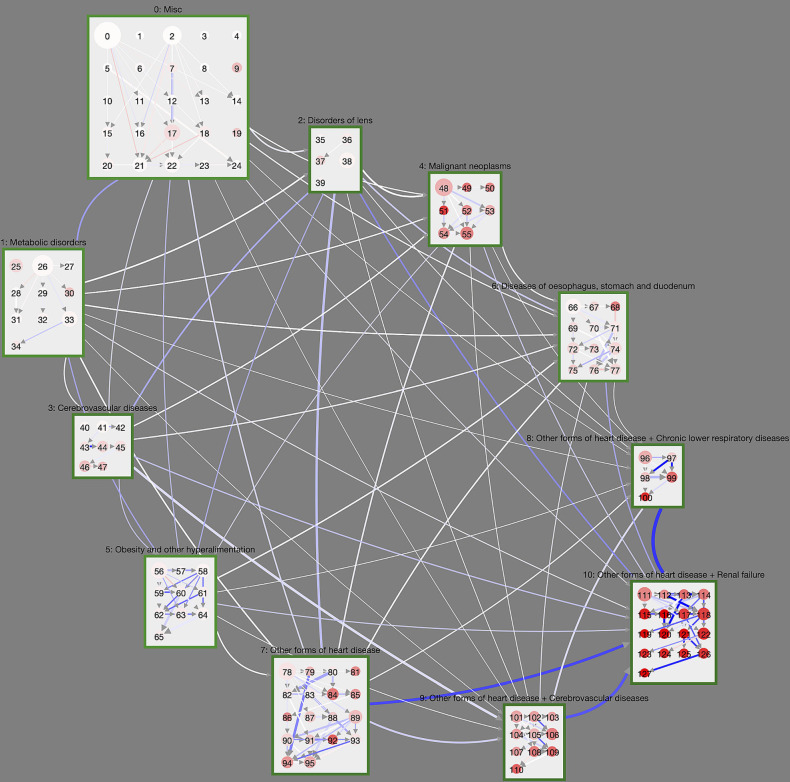
Controlled trajectory comparison of DM patients with their non-diabetic controls. We show the unfiltered disease trajectory network with weights giving the difference in cluster transition rates, RD. The more intense the blue (red), the more (less) frequent is the corresponding cluster transition in DM patients compared to non-DM patients. Almost all cluster transitions are overrepresented in DM patients, meaning that diabetes patients overall progress within shorter time-periods toward highly multimorbid health states. This is particularly the case for macro-clusters with heart diseases.